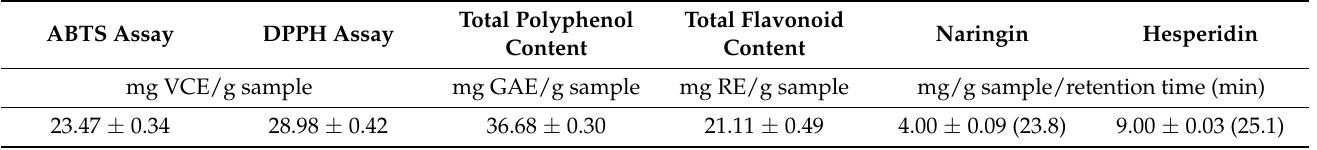
Table 1. Radical scavenging capacity and phytochemicals in